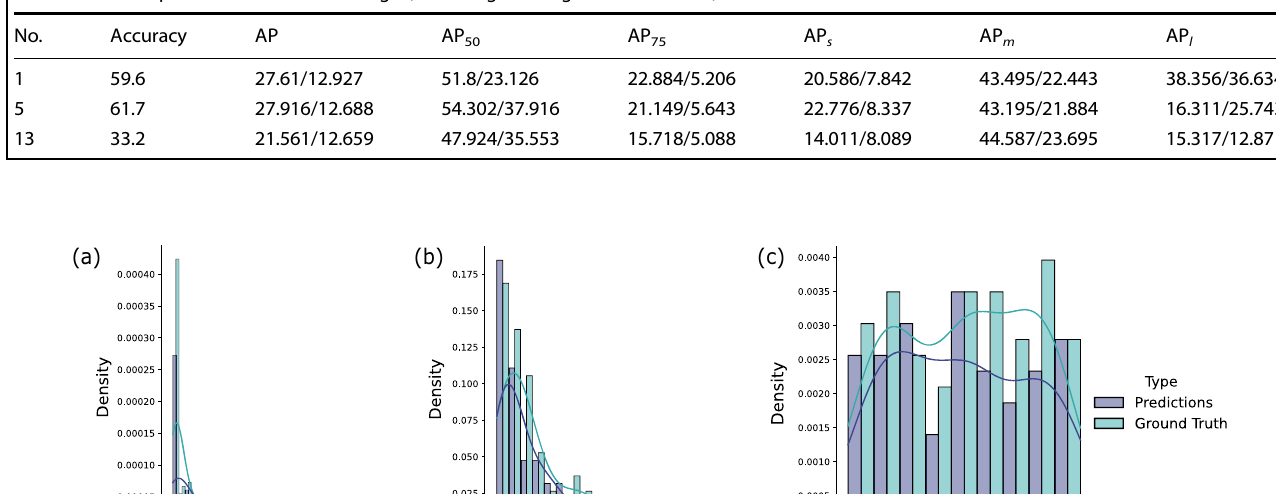
Table 4. Model performance on SEM image (bounding box/segmentation mask).